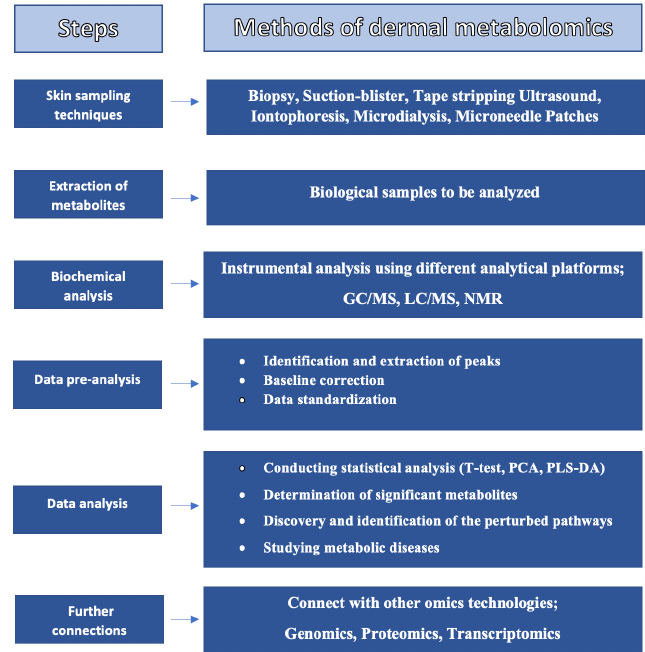
Figure 3. Process of dermal